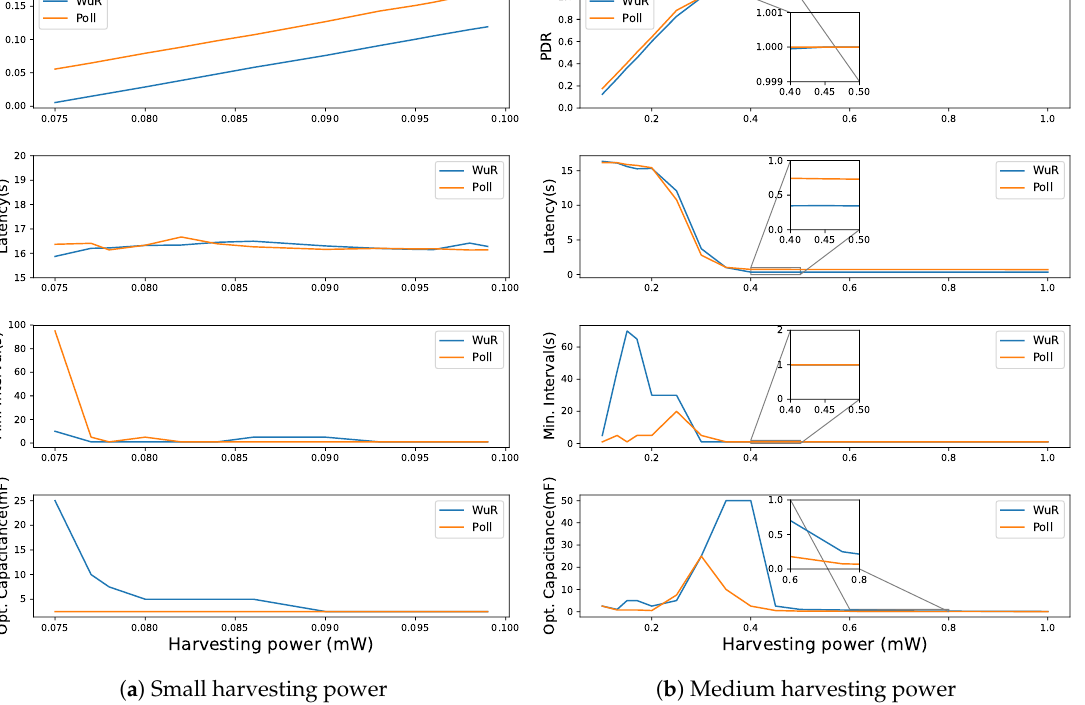
Figure 10. Comparing WuR-based and direct poll-based communication schemes for a Poisson packet arrival rate = 1